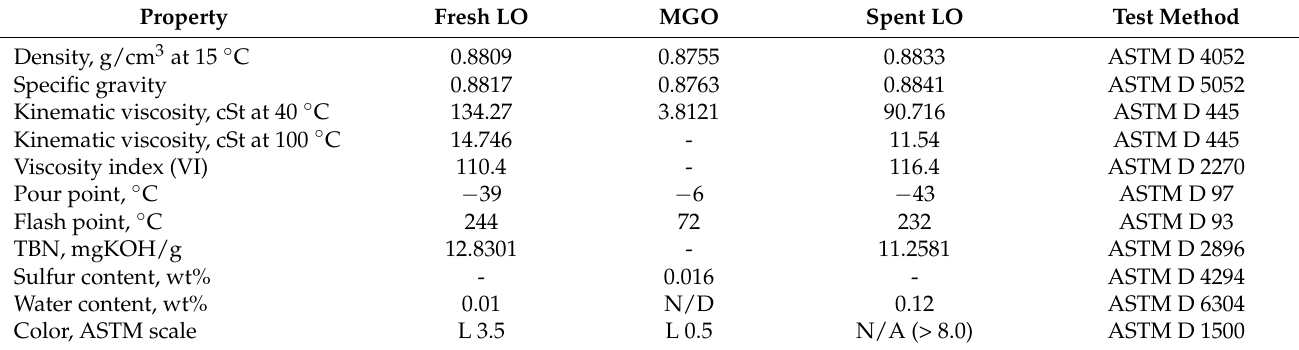
Table 1. Physicochemical properties of commercial lubricating oil (LO), marine gas oil (MGO), and spent